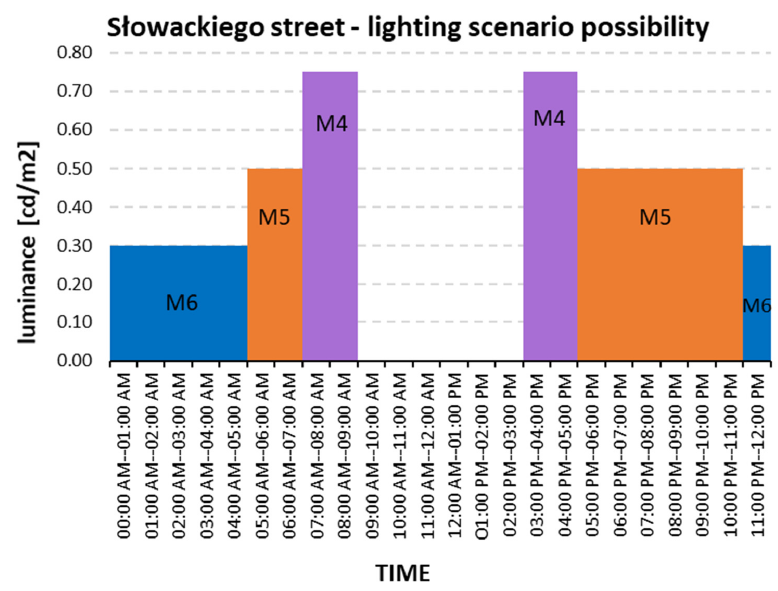
Figure 8. Luminance levels (lighting classes) for Slowackiego Street in Radzymin, acceptable by the standard, for particular periods of the day. Table 4. Possible road lighting classes depending on time of day.